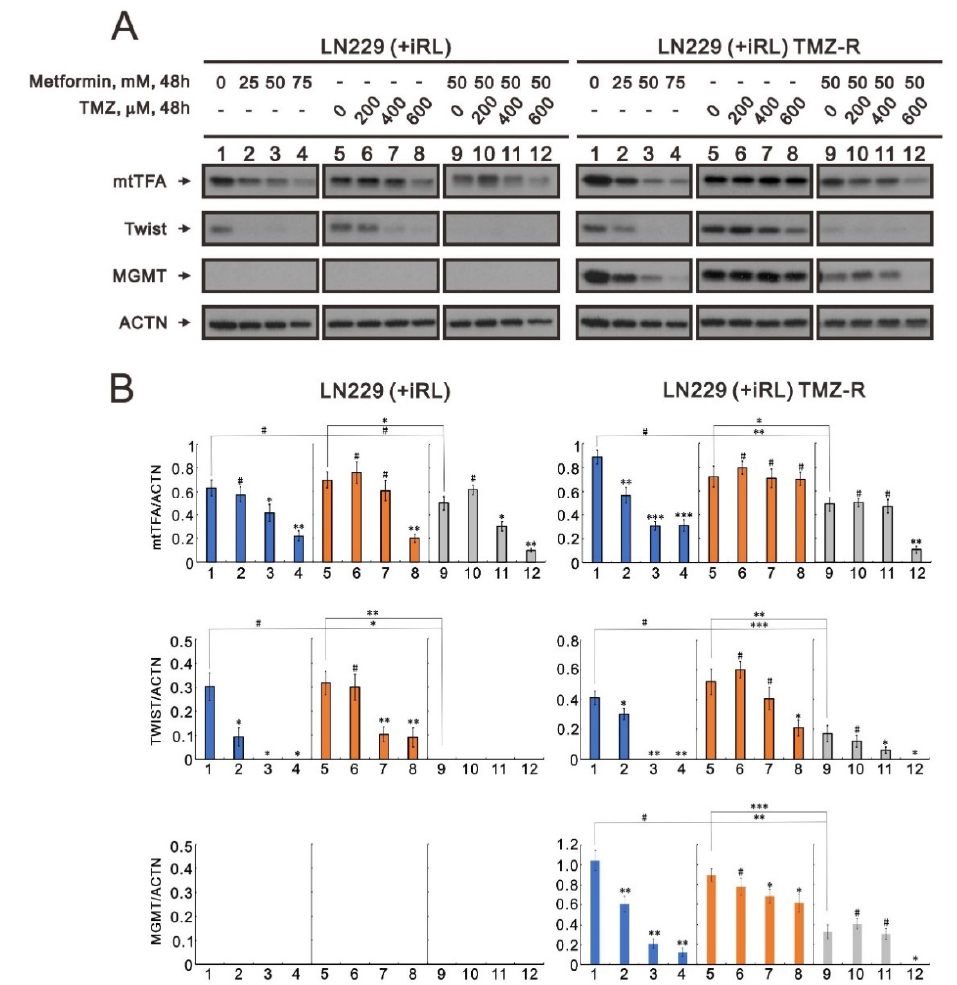
Figure 8. The effects of metformin, TMZ, and their combination on MGMT proteins in TMZ-resistant LN229 cells. LN229 parent and resistant cells, LN229 (+IRL) and LN229 (+IRL) TMZ-R cells, were treated with the indicated concentrations of metformin, TMZ, and their combination. ( A ) After 48 h, cell lysates were collected and subjected to Western blotting analysis using antibodies against mtTFA, Twist, and MGMT. ACTN was used as the protein-loading control. The protein bands were quantified through pixel density scanning and evaluated using ImageJ, version 1.44a (http://imagej.nih.gov/ij/) (accessed on 15 July 2022). ( B ) The ratios of mtTFA/ACTN, TWIST/ACTN, and MGMT/ACTN were plotted in the LN229 (+IRL) and LN229 (+IRL) TMZ-R cells. The results are representative of three independent experiments. # p > 0.05, * p < 0.05, ** p < 0.01, and *** p < 0.001.